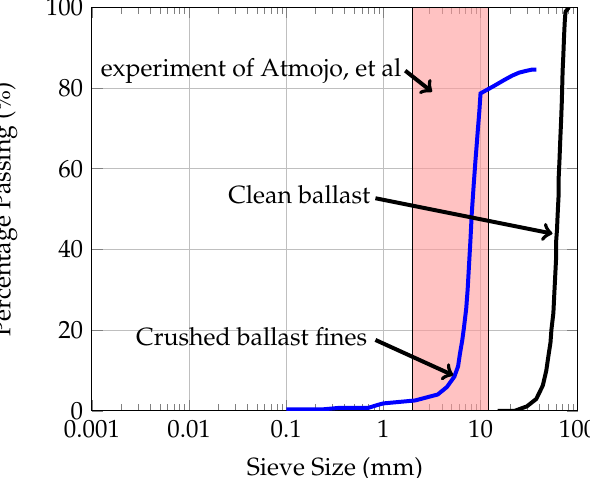
Figure 3. Grain size distribution for ballast as reported in [14]. The red area represents the gradation of the ballast for Atmojo’s experiment.